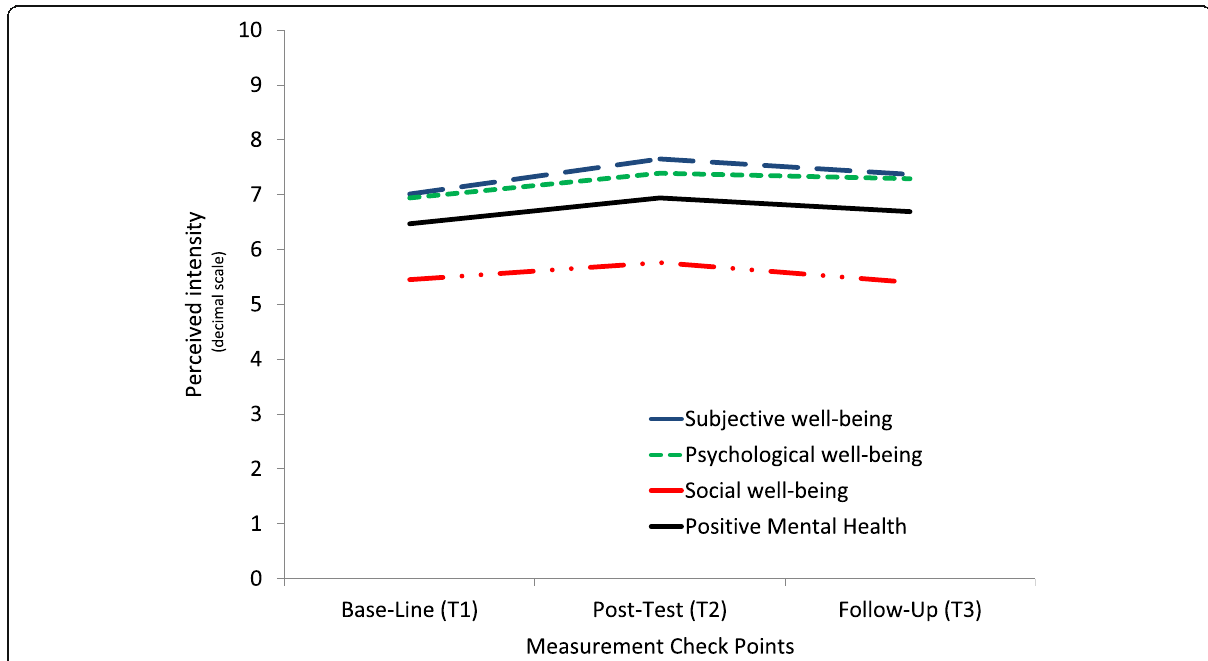
Fig. 1 Repeated measures trends of the principal outcomes